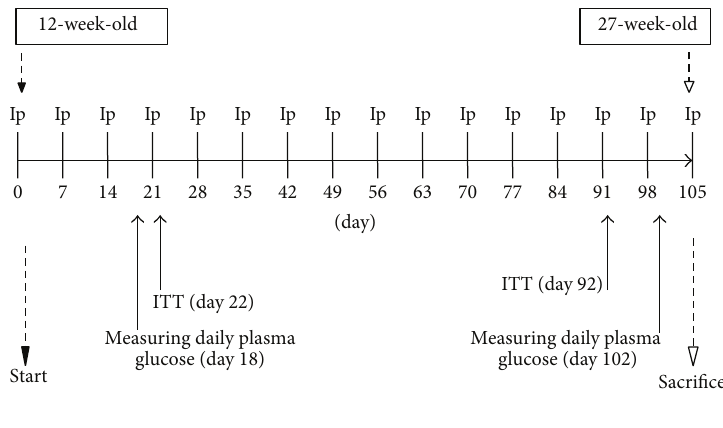
Figure 1: Experimental protocol. Mice of the control group ( 𝑛 = 22 ) were provided with water by oral gavage twice a day (9:00 AM and 4:00 PM) and received intraperitoneal injections of 10mL/kg saline in the morning once a week. Mice of the glucose group ( 𝑛 = 22 ) were provided with glucose (2.0g/kg) by oral gavage twice a day and received intraperitoneal injections of 10mL/kg saline once a week. Mice of the glucose (2.0 g/kg) plus ipragliflozin group ( 𝑛 = 22 ) were provided with glucose (2.0 g/kg) twice a day and ipragliflozin (3mg/kg) once a day by oral gavage and received intraperitoneal injections of 10 mL/kg saline once a week. Mice of the insulin group ( 𝑛 = 22 ) were provided with water by oral gavage twice a day and received intraperitoneal injections of 8IU/kg insulin once a week. Mice of the glucose plus insulin group ( 𝑛 = 22 ) were provided with glucose (2.0 g/kg) by oral gavage twice a day and received intraperitoneal injections of 8 IU/kg insulin once a week.